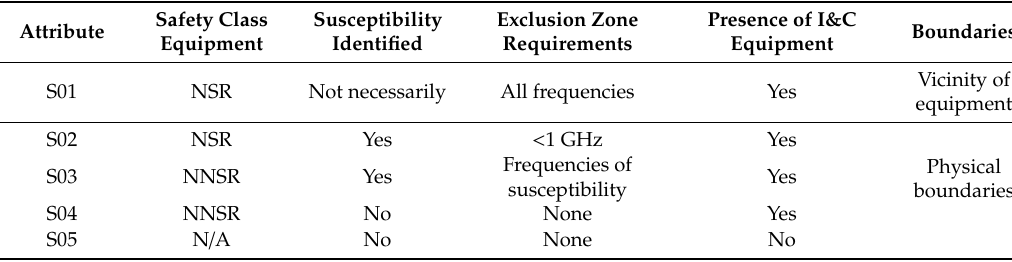
Table 1. Summary of susceptibility zone attributes